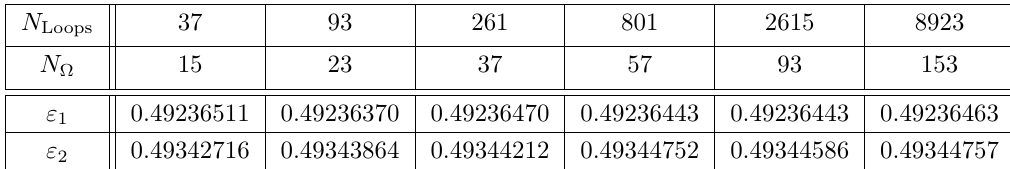
Table 9. The two lowest lying states for k = g 4 = 0 and g 3 = 0 . 05 / 3 = 0 . 0167 .